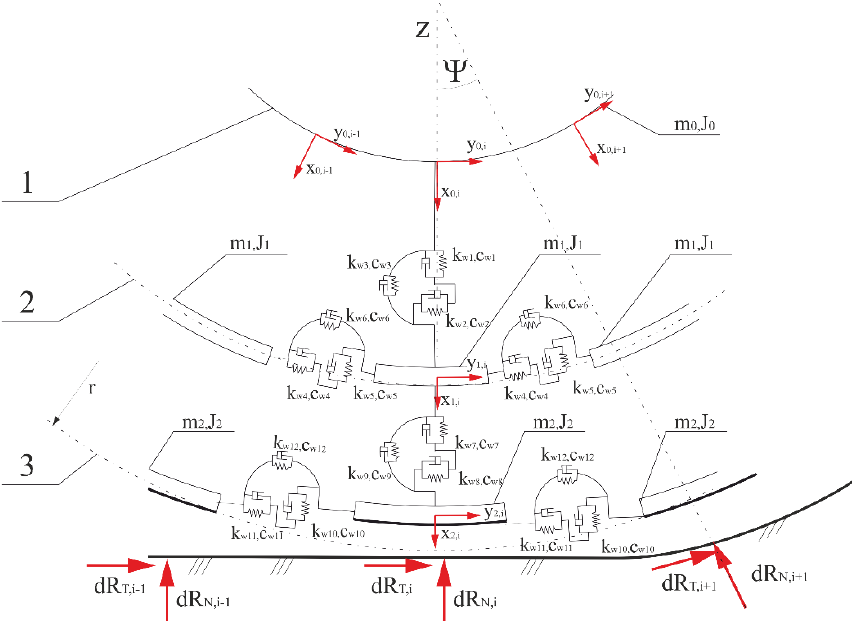
Figure 5. Wheel model structure: 1—wheel rim; 2—carcass; 3—thread; dR N,i —elementary normal reaction of the substrate; dR T,i —elementary tangential reaction of the substrate; ψ i —angle of operation of an elementary normal force measured from a vertical line Z [14].